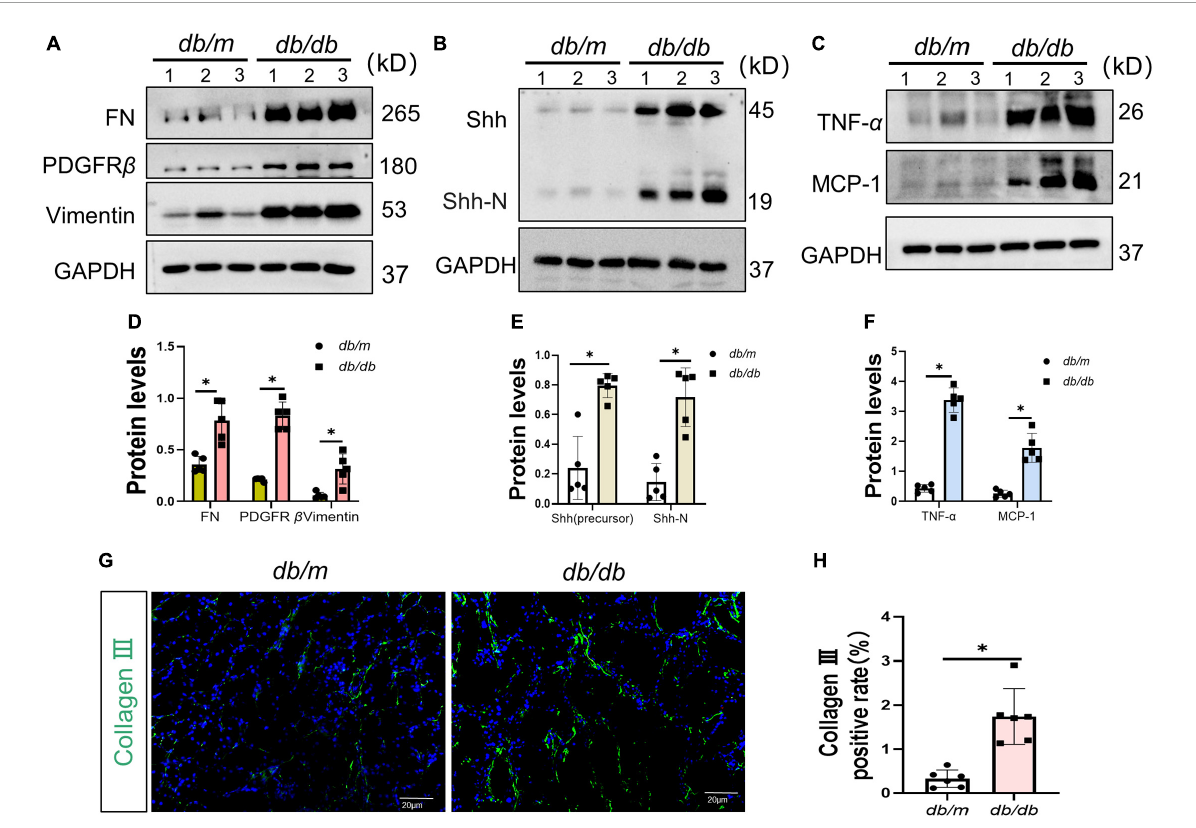
FIGURE3 Fibrosis and senescence-associated secretory phenotype (SASP) in the process of diabetic kidney disease (DKD). (A,D) Western blot analyses showed FN, PDGFR- β , and Vimentin protein in renal tissues. Representative Western blot (A) and quantitative data (D) are presented. (B,C,E,F) Western blot analyses showed Sonic hedgehog (Shh) (precursor), Shh-N, tumor necrosis factor-alpha (TNF- α ), and MCP-1 protein in renal tissues. Representative Western blot (B,C) and quantitative data (E,F) are presented. (G,H) Representative micrographs showed immunofluorescence staining of Collagen-III in different groups (G) , and quantitative analysis (H) . DAPI staining (blue) represents cell nucleus, Bar = 20 µ m. All data are presented as mean ± standard deviation (SD) from three independent experiments. n = 5; ∗ P < 0.05 vs. db/m